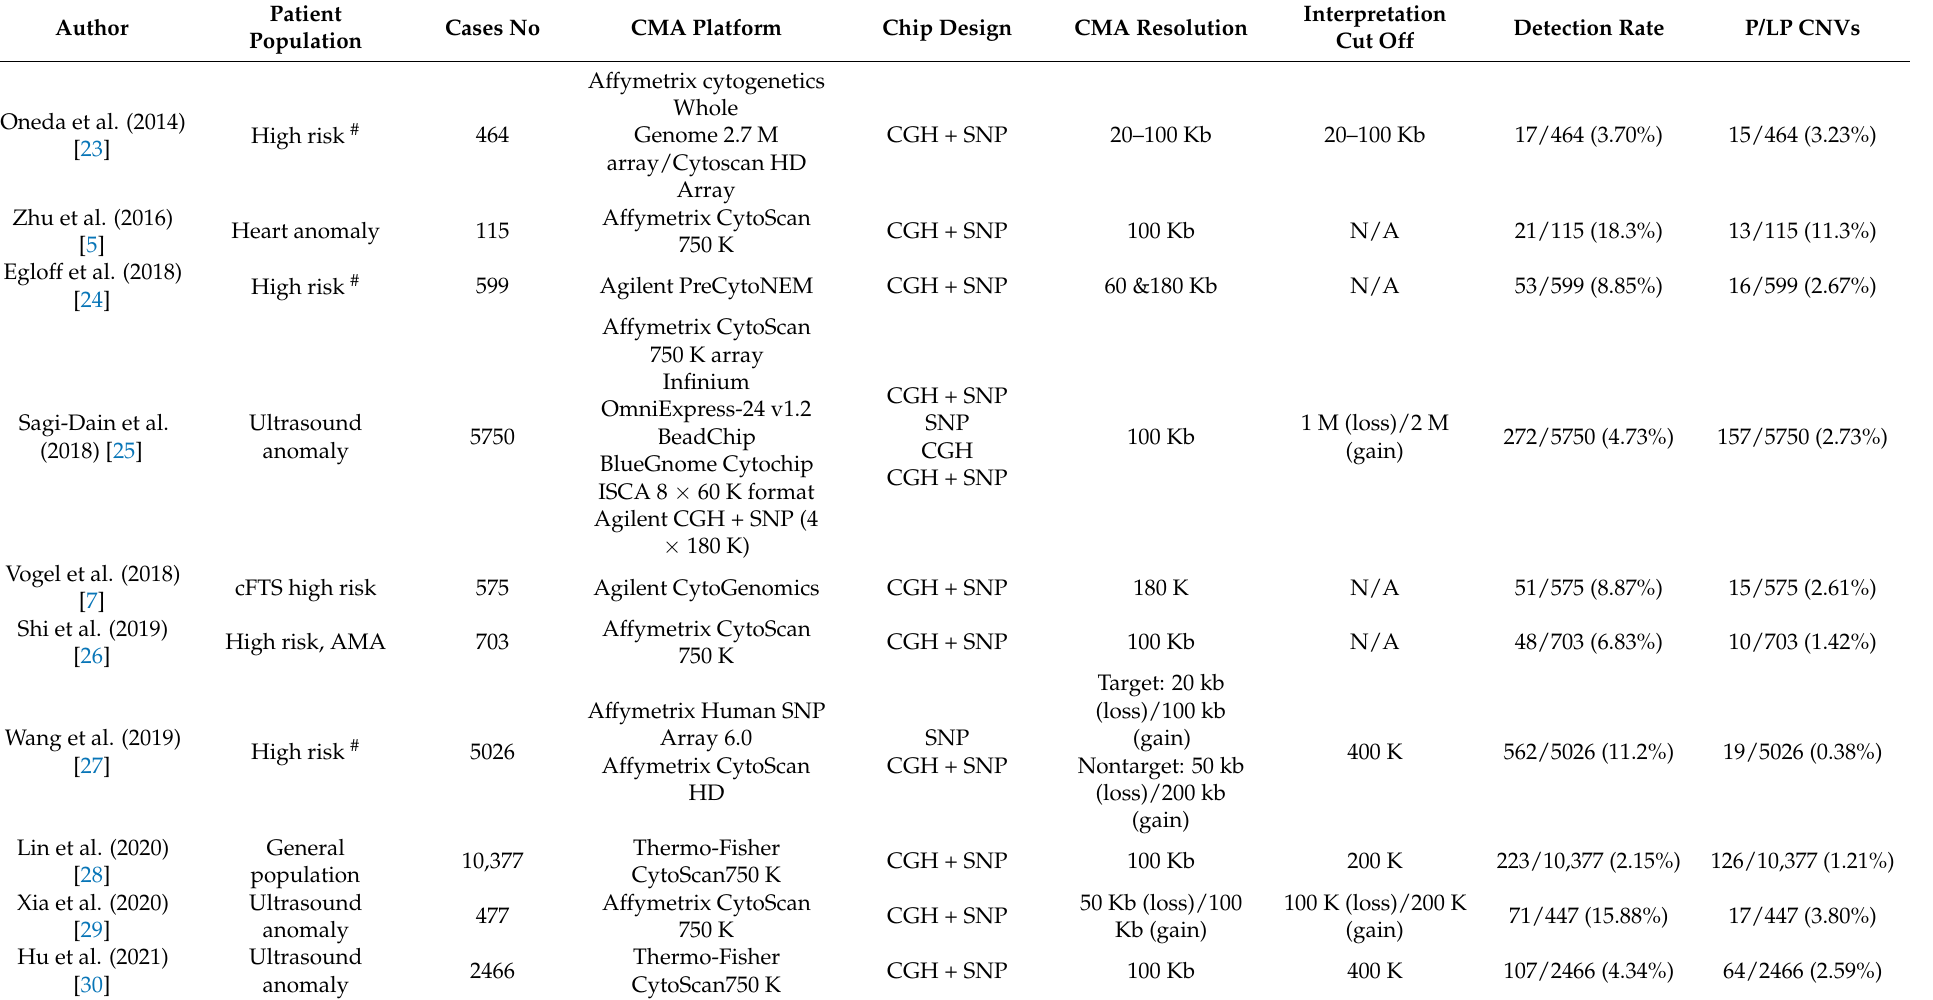
Table 3. Overview of current CMA platforms and interpretation of prenatal examinations in the